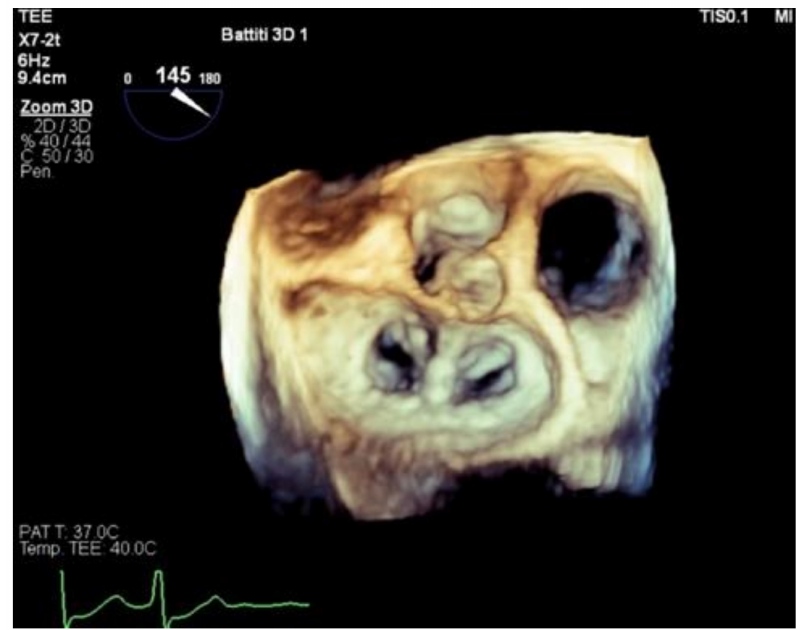
Figure 3. MitraClip implantation with characteristic double-orifice valve at three-dimensional (3D) trans-esophageal echocardiography